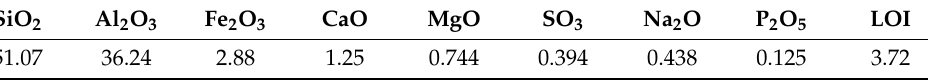
Table 3. Chemical constituents of fly ash (wt%).